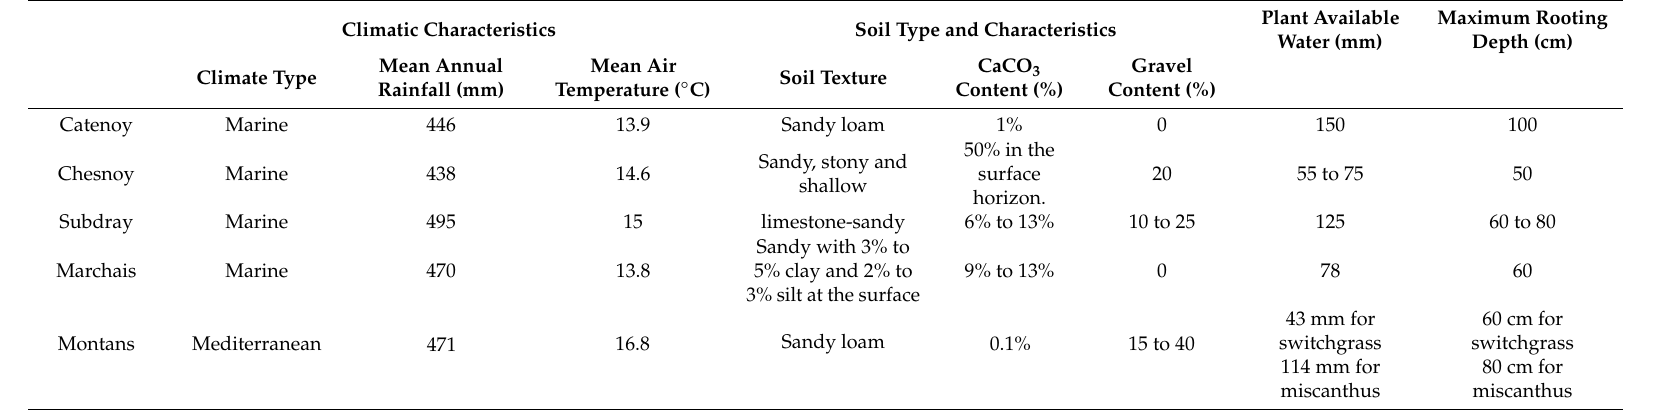
Table 2. Pedoclimatic and management characteristics of the Lignoguide experimental